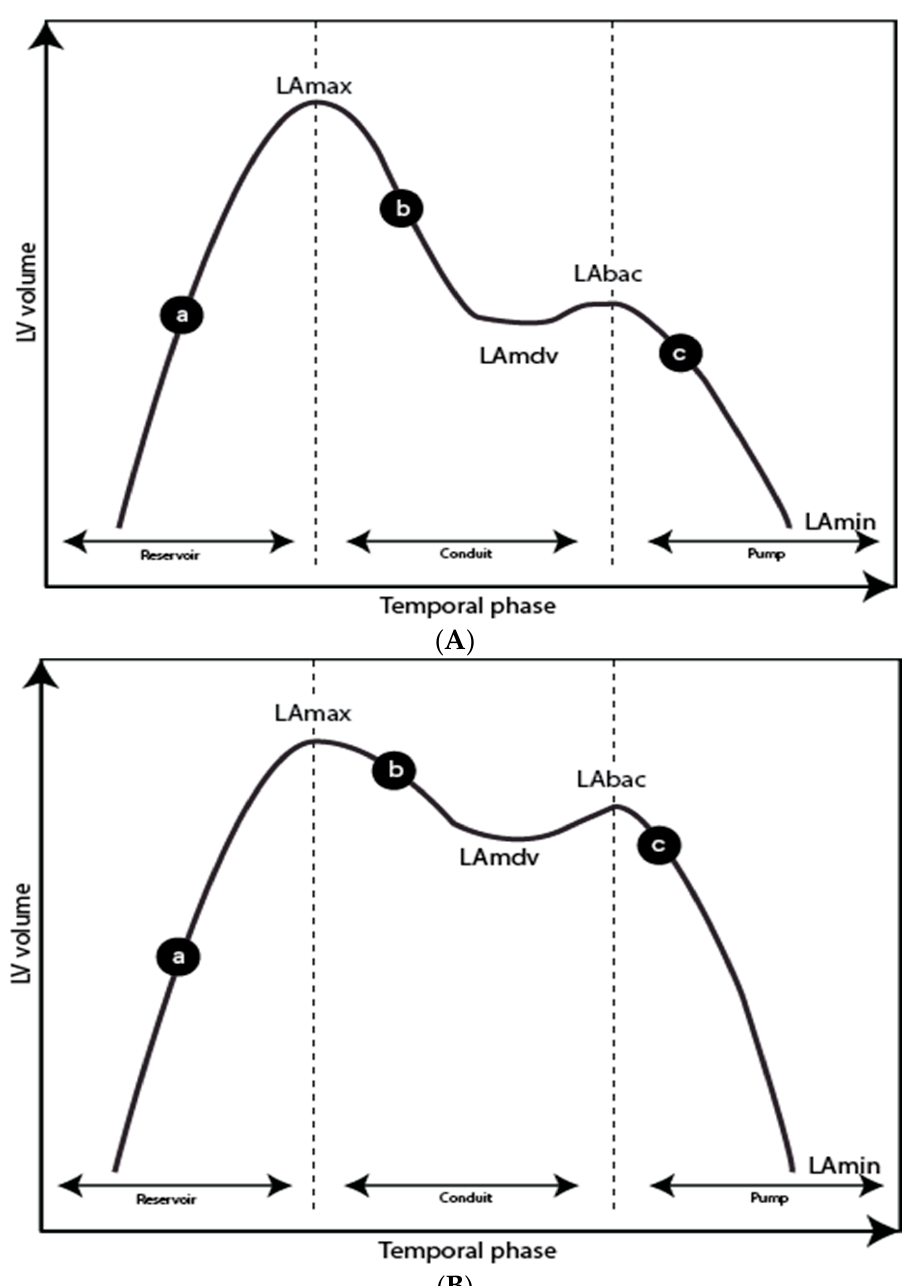
Figure 5. Left atrial (LA) time-volume curves for a normal subject ( A) and a patient with diastolic impairment ( B ). (a) LA filling during left ventricular systole, (b) LA passive emptying, (c) LA contraction. LA max , left atrial maximum volume; LA mdv , left atrium mid-diastolic volume and plateau phase; LA bac , left atrium before atrial contraction; LA min , left atrium minimum volume. Reservoir function: Total emptying volume (TEV)= LAmax-LAmin; Total emptying fraction = TEV/LAmax×100. Conduit function: Passive emptying volume (PEV) = LAmax-LAmdv; Passive emptying fraction (PEF) = PEV/LAmax×100; Conduit volume: Stroke volume-TEV. Pump function: Active emptying volume (AEV) = LAbac-LAmin; Active emptying fraction = AEV/LAmax×100.